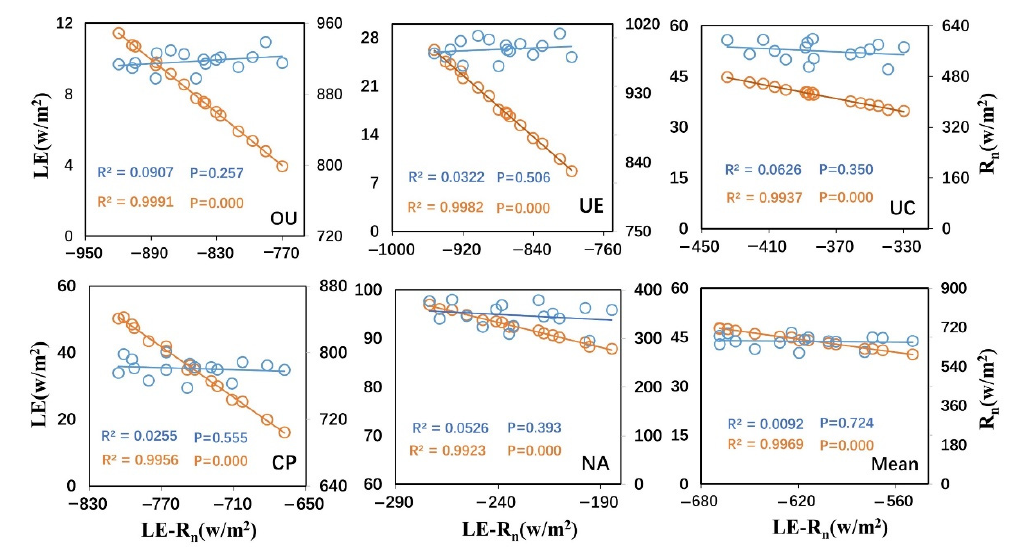
Figure 13. Correlation between and LE, 𝑅 (cid:3041) and LE − 𝑅 (cid:3041) under the five land types in the influence area of the YRB from 2000 to 2015 (blue dots and blue lines represent scatter plots with LE − 𝑅 (cid:3041) , with LE, orange dots and orange lines represent LE − 𝑅 (cid:3041) scatter plots with 𝑅 (cid:3041) ).